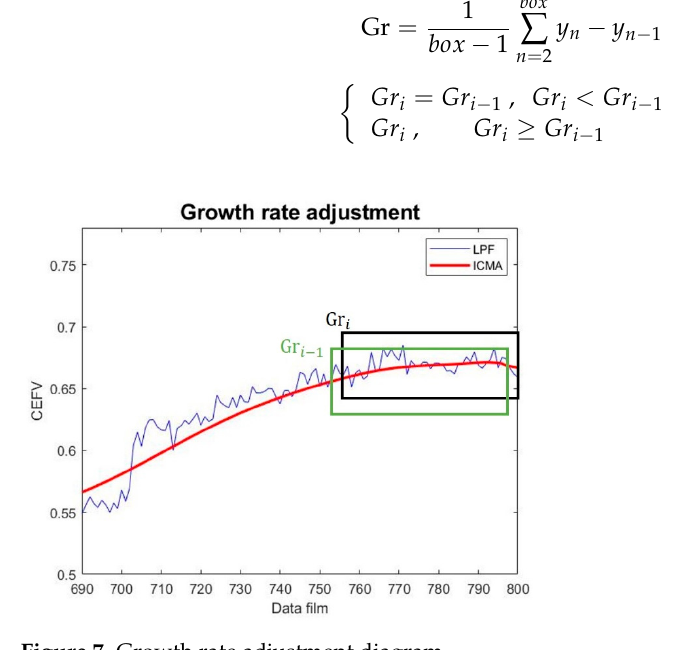
Figure 7. Growth rate adjustment diagram.